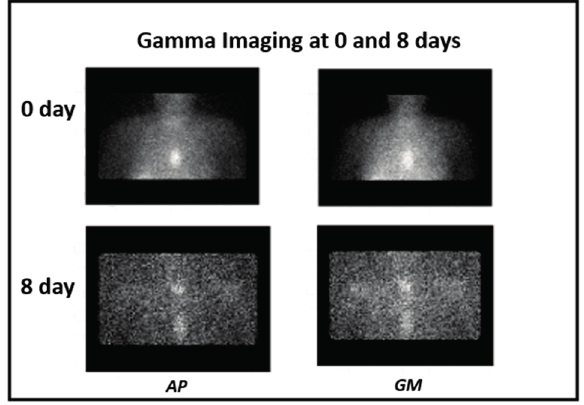
Figure 5. Gamma imagings at 0 and 8 days after 223 RaCl 2 therapeutic dose using gamma camera, AP-views on the left and geometric mean images on the right. This patient has a lesion in the sternum and in the thoracic